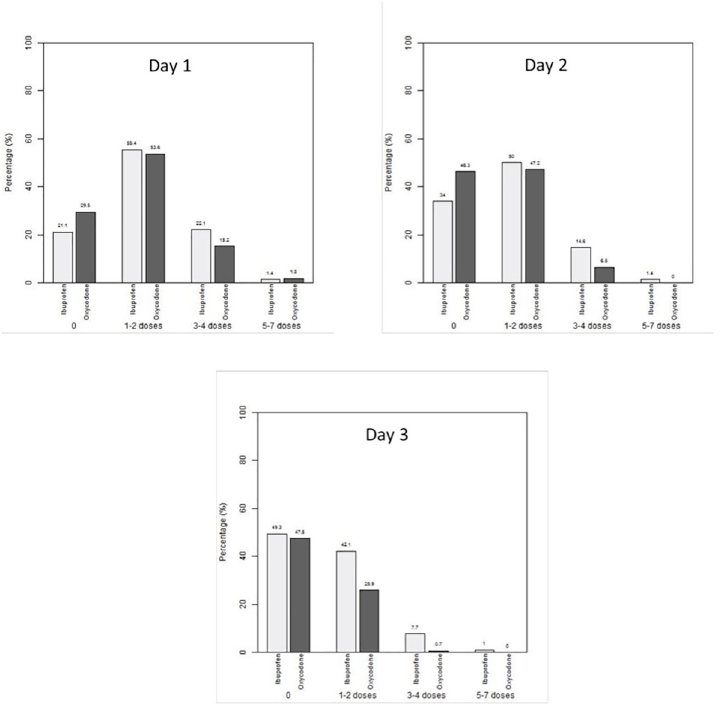
Fig 1. Number of doses of recommended medication used per day (Days 1–3).